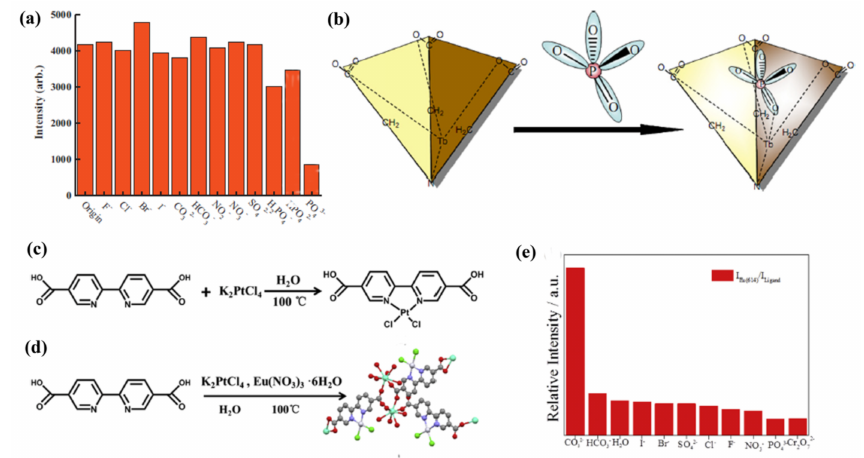
Figure 5. ( a ) Comparison of the 5 D 4 → 7 F 5 transition intensities of TbNTA solid activated in 10 − 2